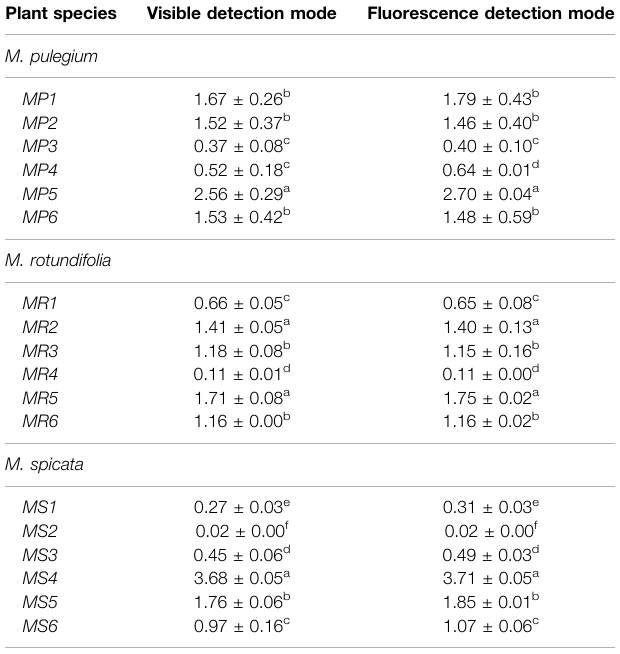
TABLE 4 | Rosmarinic acid content (mg/100 g of dry matter) determined by HPTLC for the three Mentha species collected from different regions of Algeria.